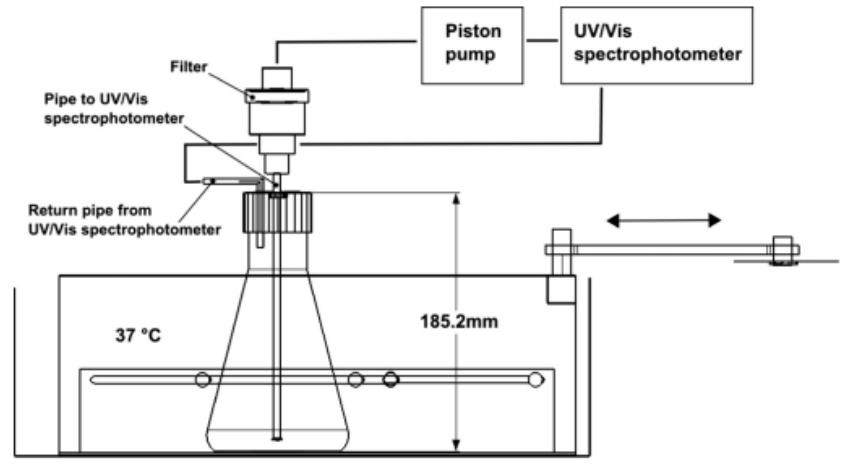
Figure 7. Schematic of the “custom-built stomach model”. Reprinted from Reference [61] with permission from Elsevier.